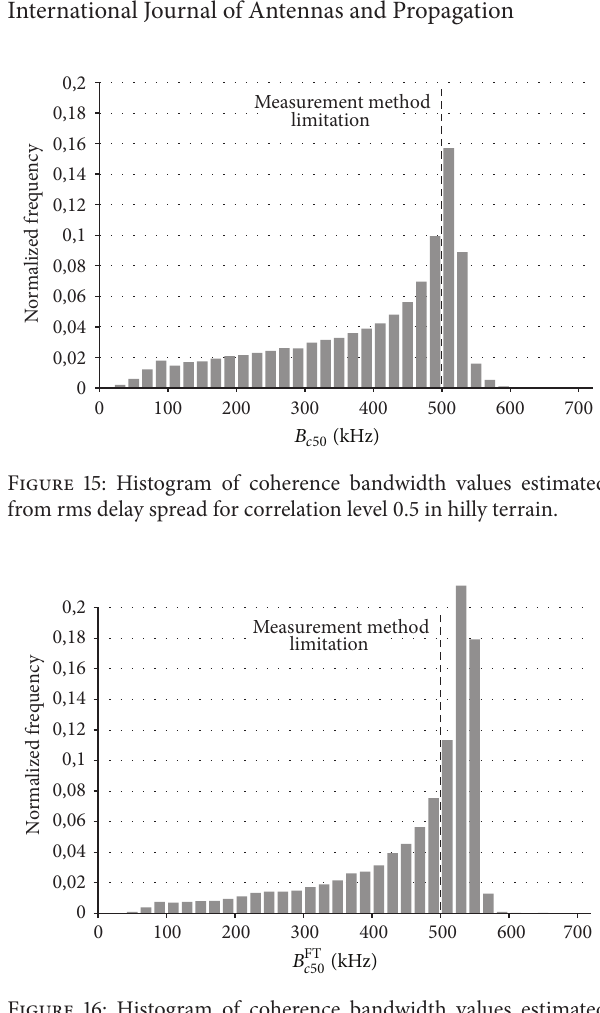
Figure 16: Histogram of coherence bandwidth values estimated from Fourier transform of PDP for correlation level 0.5 in hilly terrain.